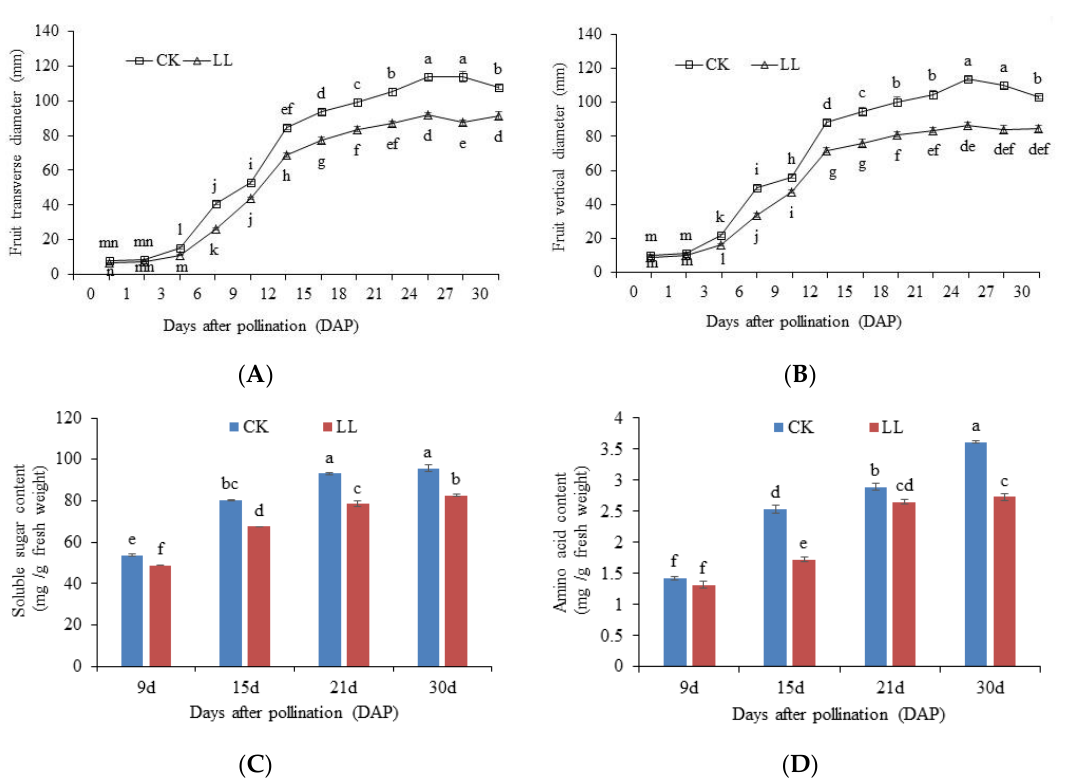
Figure 1. Watermelon fruit dynamic development under low-light stress. ( A ) Fruit vertical diameter. ( B ) Fruit transverse diameter. ( C ) Fruit soluble sugar content. ( D ) Fruit amino acid content. Error bars represent standard errors. Different letters (a, b, c, d, e, f) indicate significant statistical differences ( p < 0.05).